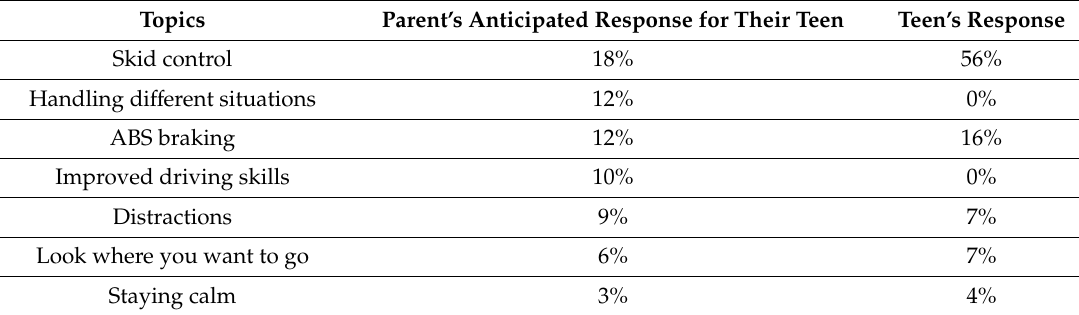
Table 3. Most important thing learned for the parent’s anticipated response for their teen and the teen’s